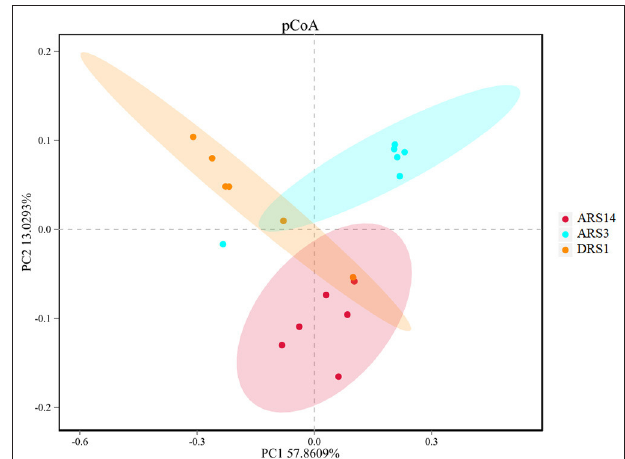
FIGURE 2 | Principal coordinate analysis plot of total microbiota in rumen samples of 3 stages after rumen fistula surgery in sheep. PC1, principal component 1; PC2, principal component 2. DRS1, 1d during the rumen surgery; ARS3, 3d after the rumen surgery; ARS14, 14d after the rumen